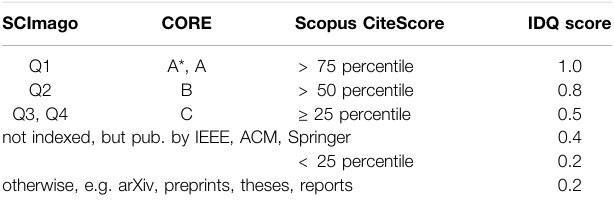
TABLE 2 | Mapping from popular venue rankings to our uni fi ed intrinsic data quality (IDQ). SCImago